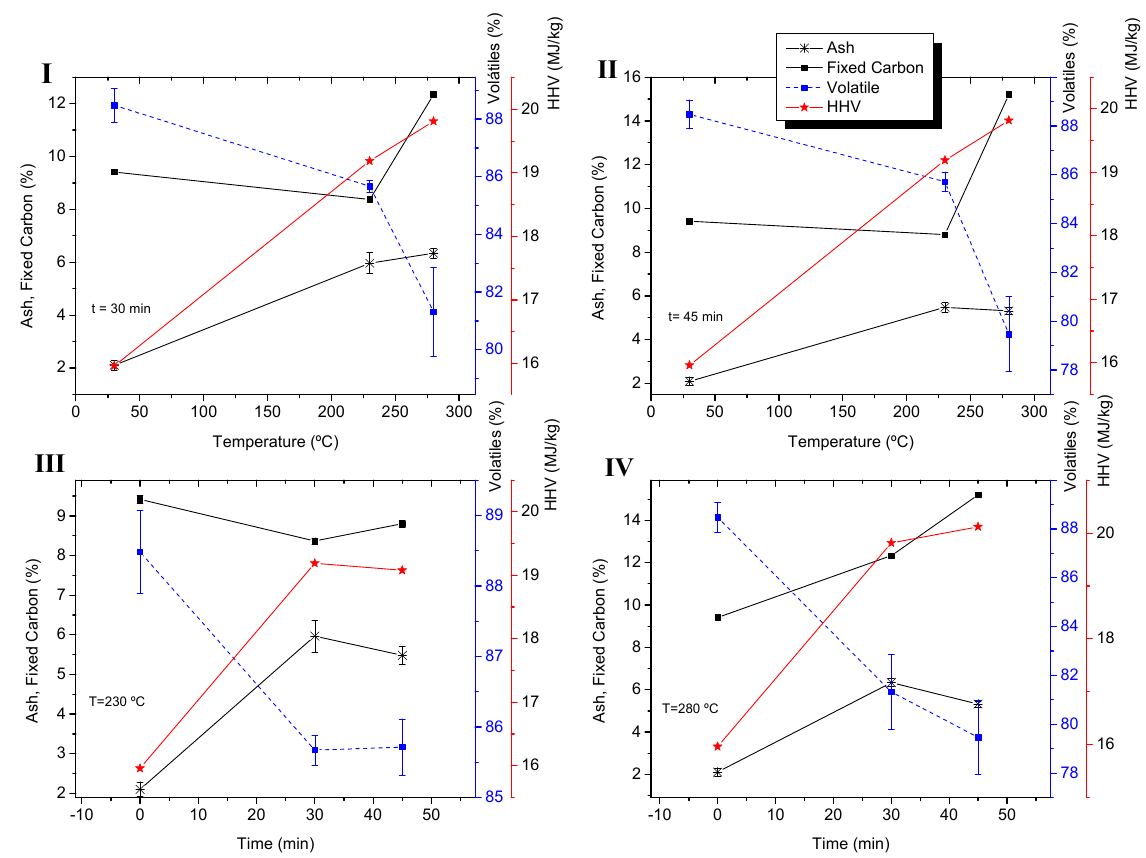
Figure 3. Effects of torrefaction temperatures ( I , II ) and residence times ( III , IV ) on proximate analysis of sugarcane ba- gasse.